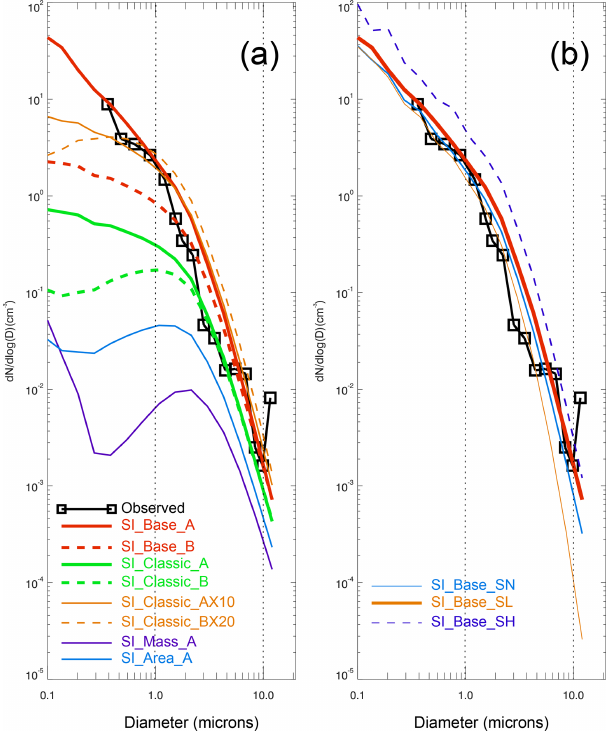
Figure 5. Averaged SSA size distribution from the whole sea ice zone (including both marginal and packed sea ice). Observations are shown in the black line with box symbols. Panel (a) con- tains model runs with different parameters, including four differ- ent sublimation functions (in SI_Base, SI_classic, SI_Area and SI_Mass), two blowing-snow size distributions (mode A vs. B) and two different ratios of SSA formation per blowing-snow particle (in SI_Classic_AX10 and SI_Classic_BX20) (see Table 1 for details). Panel (b) shows model sensitivity to snow salinity. SI_Base_A_SN is the same as the control run (SI_Base_A), apart from removing samples with salinity > 10psu. SI_Base_A_SL applies a fixed low salinity of 0.06psu, and SI_Base_A_SH applies a high value of 0.92psu. Vertical lines represent a diameter of 1 and